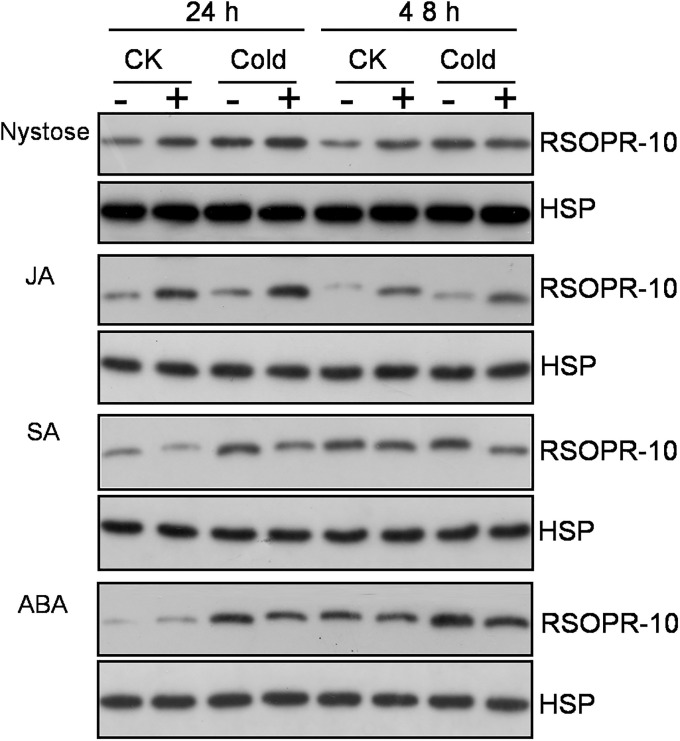
Western blot analysis of RSOsPR10 expression in response to nystose, JA, SA, and ABA.CK: rice roots grown at 25°C for 2 d after the treatment. Cold: rice roots grown at 4°C for 2 d after the treatment. “-“: seeds treated with water; “+”: seeds treated with 2.5 mg/L JA, 5 mg/L SA, 2.5 mg/L ABA, or 75mg/L nystose.